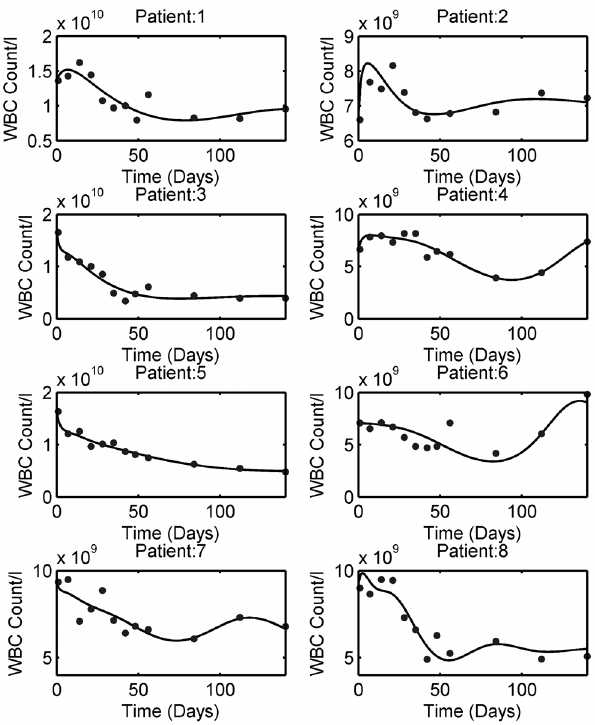
Figure 8. Leukopoiesis model fit to individual patient data obtained from literature. Solid dots indicate the individual patient WBC count and solid lines represent the model fit. The estimated patient-specific parameters are provided in Table 5. The model mimics diverse behavior observed during 6-MP treatment.